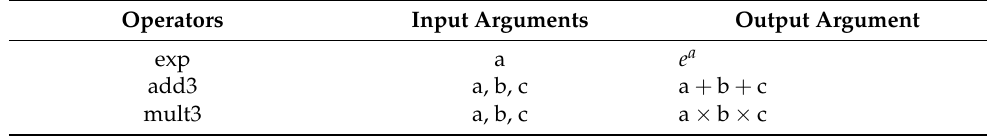
Table 3. Examples of GP operators and their meanings.